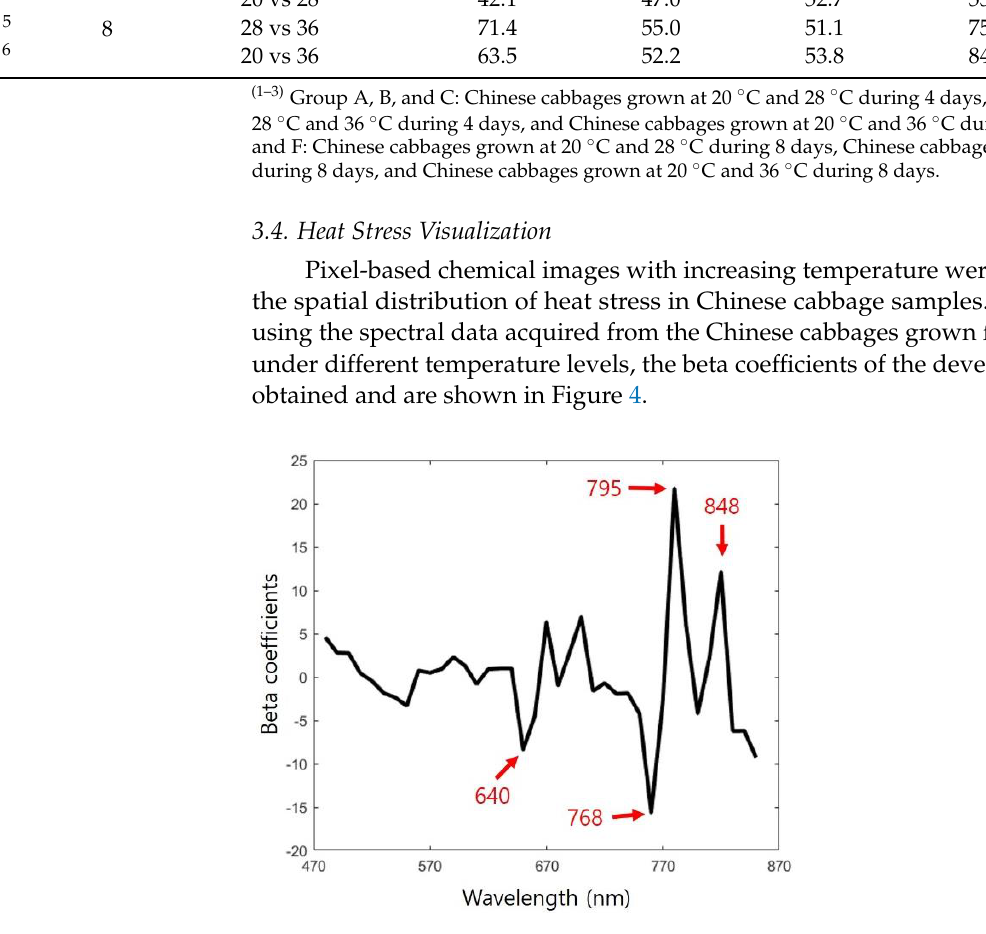
Figure 4. Beta-coefficient plot of the partial-least squares model acquired from snapshot-based multispectral images of Chinese cabbages grown for 4 and 8 days.